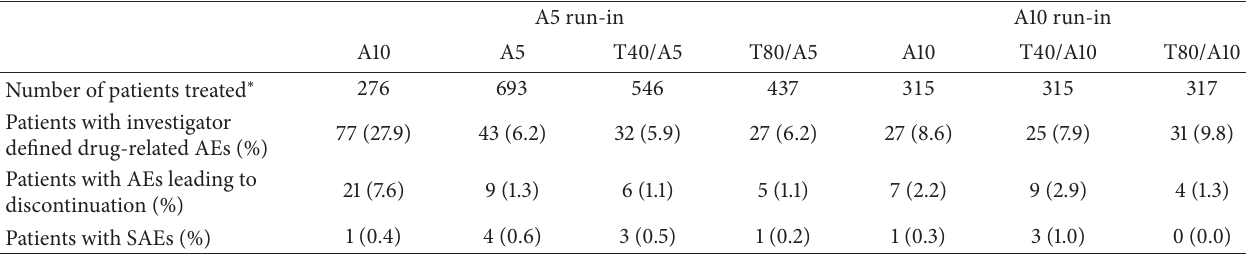
Table 5: Adverse event